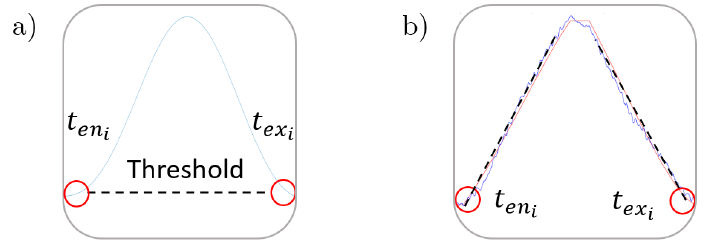
Figure 6. Time parameters measurement. ( a ) Threshold-based algorithm. ( b ) Slope-based